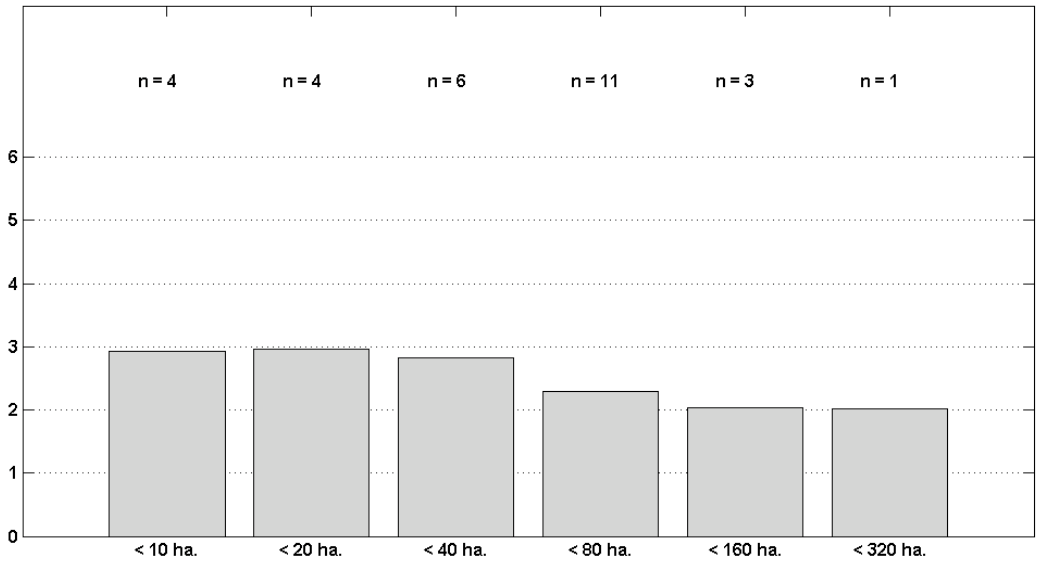
Figure A2.10: Modeled cattle stocking density in head/ha as a function of property size. The n for each bar represents the number of properties of that size in the